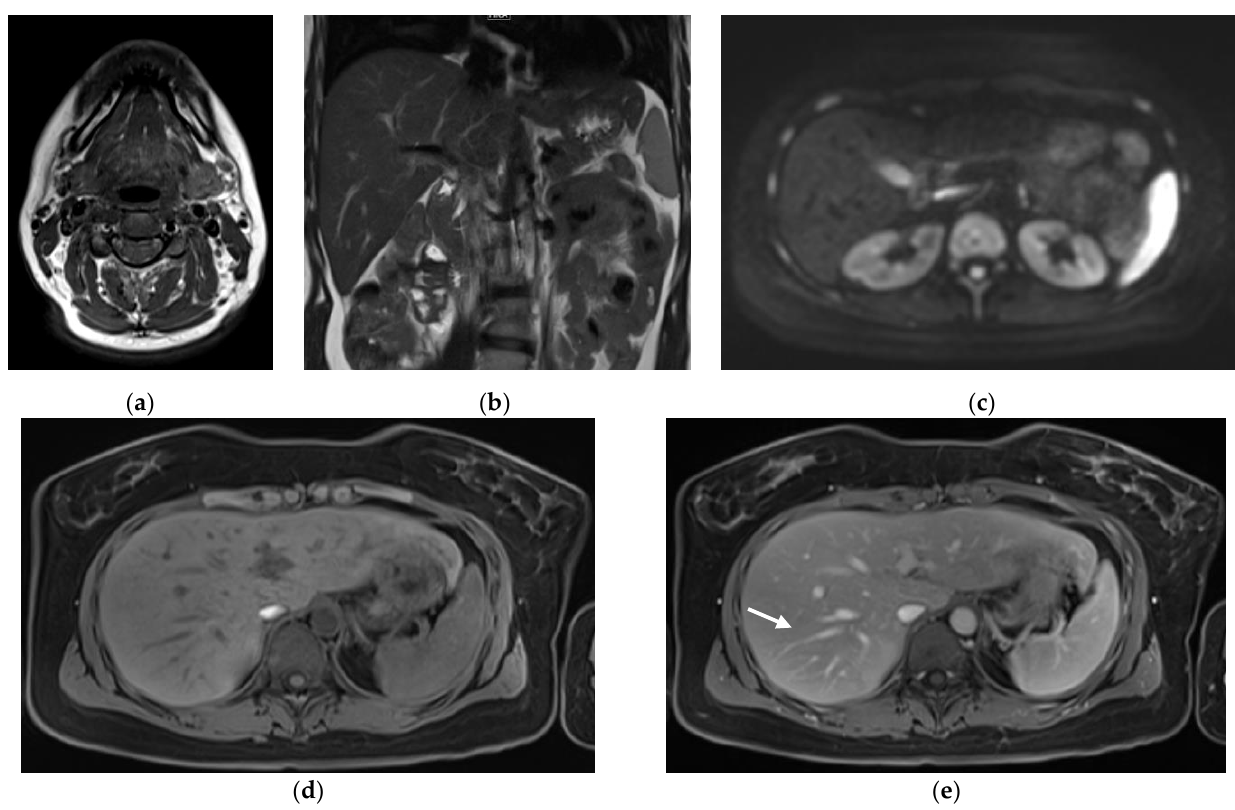
Figure 1. Images illustrating the 20-min-WB-MRI-protocol: example of axial T1-weighted (T1w) TSE Dixon of the neck ( a ), coronal T2-weighted (T2w) HASTE of the upper abdomen ( b ), simultaneous multislice diffusion-weighted imaging of the abdomen and pelvis ( c ), and axial pre- ( d ) and post-contrast T1w VIBE Dixon from thorax to pelvis ( e ) in a 36-year old patient with malignant melanoma and currently no evidence of disease. Note that the sharpness of the anatomic structures, such as the liver vessels (arrow), was rated as excellent. Please note that the images have been cropped, as the skin tissue was part of the